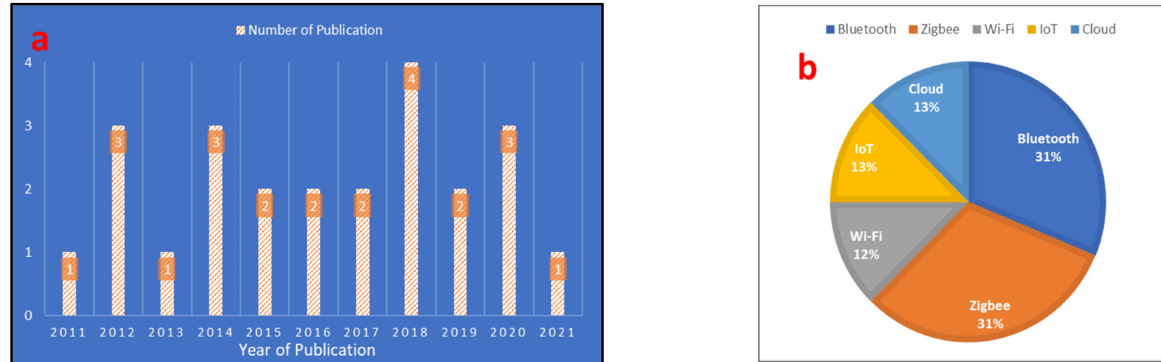
Figure 3. Trends of WBMS research: ( a ) Based on the number of publications per year, ( b ) Based on wireless communication topology